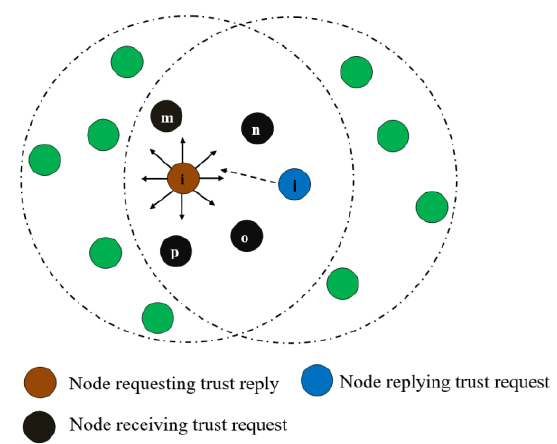
Figure 5. Process of trust derivation.